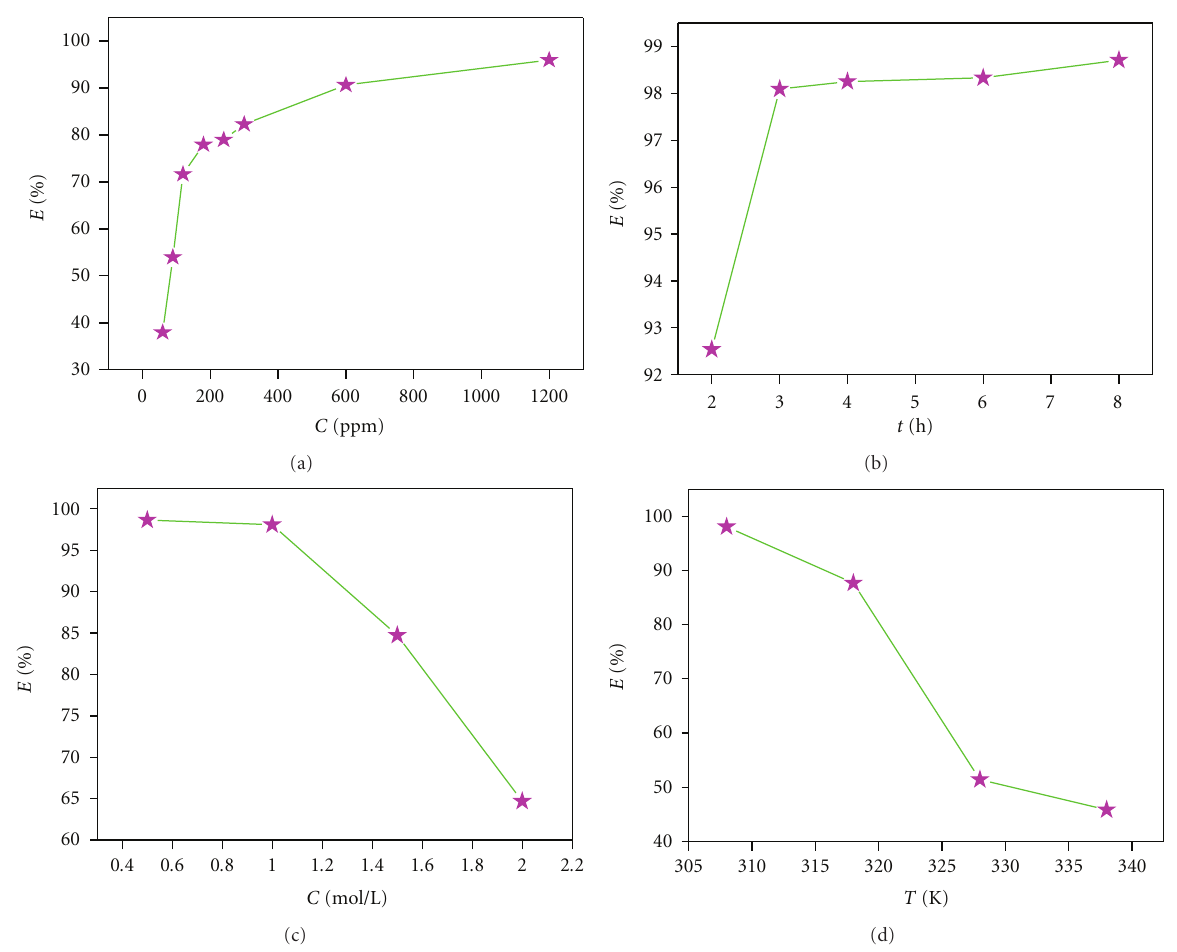
Figure 1: Variation of inhibition e ffi ciency of Kalmegh ( Andrographis paniculata ) extracts in 1M HCl with (a) extract concentration, (b) immersion time, (c) acid concentration, and (d) temperature of the solution.